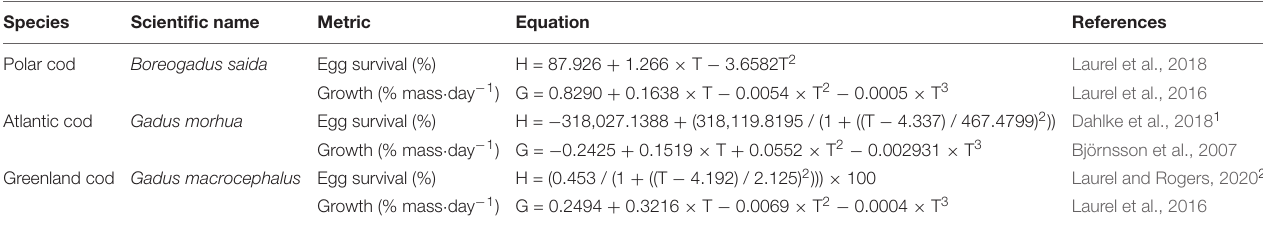
TABLE 1 | Cod development models for growth potential and egg